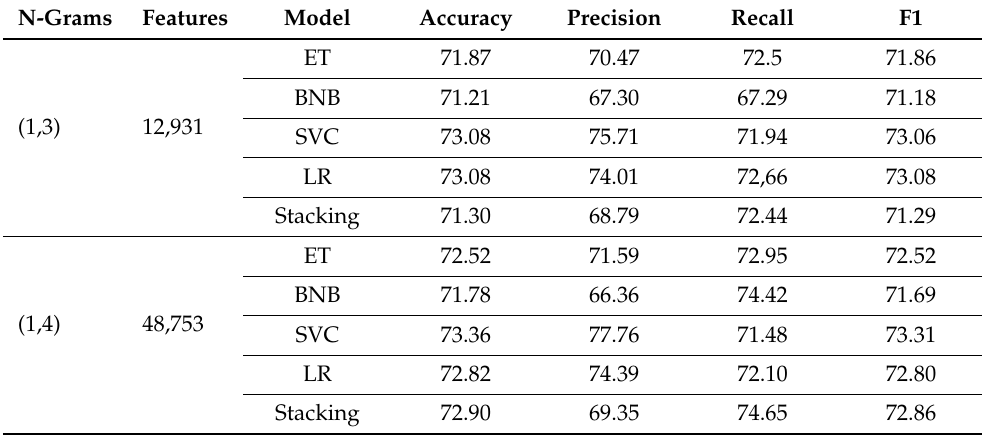
Table 9. Threatening language detection using N-gram range for BoW